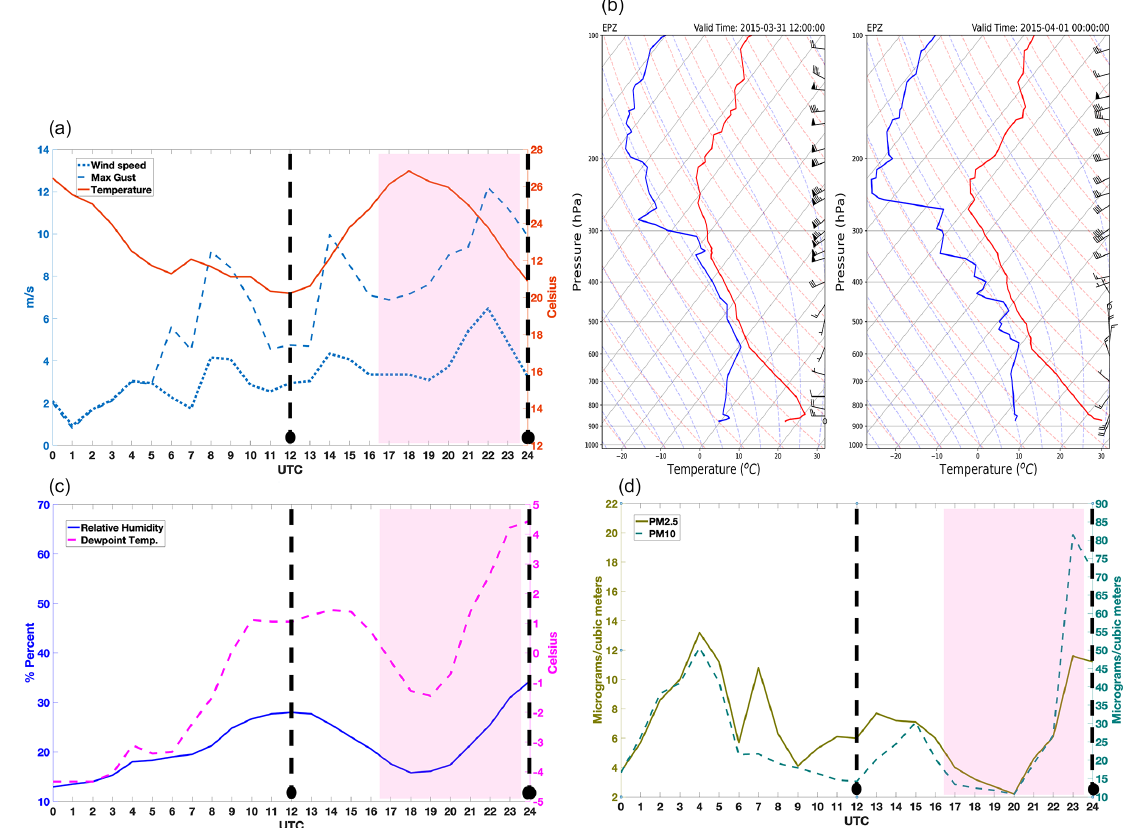
Figure 6. Hourly measurements from TCEQ CAMS 12 UTEP for 31 March 2015. (a) Wind speed (dotted blue), maximum wind gust (dashed blue; ms − 1 ), and surface temperature (red; ◦ C). (b) Sounding along with wind barbs from NWS for 31 March 2015 at 12:00UTC and 1 April 2015 at 00:00UTC ( T d in blue; T in red). (c) Relative humidity (purple) and dew point temperature (dashed pink). (d) PM 2 . 5 concentration (olive) and PM 10 concentration (dashed teal). Shaded portions represent virga events, and dashed black lines and dots represent the availability of radiosonde data.